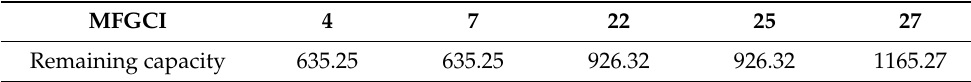
Table 3. Remaining capacity of MFGCI at 7:00 (kW).